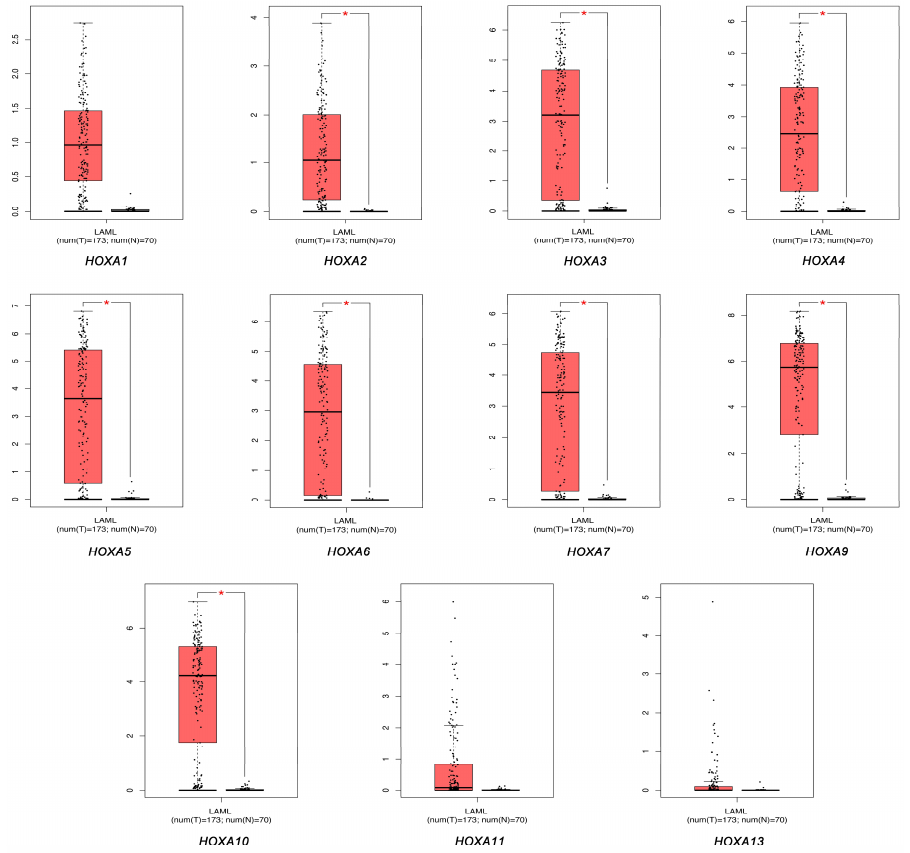
Figure 2. The expression of HOXA genes in acute myeloid leukemia (AML) and healthy control samples.